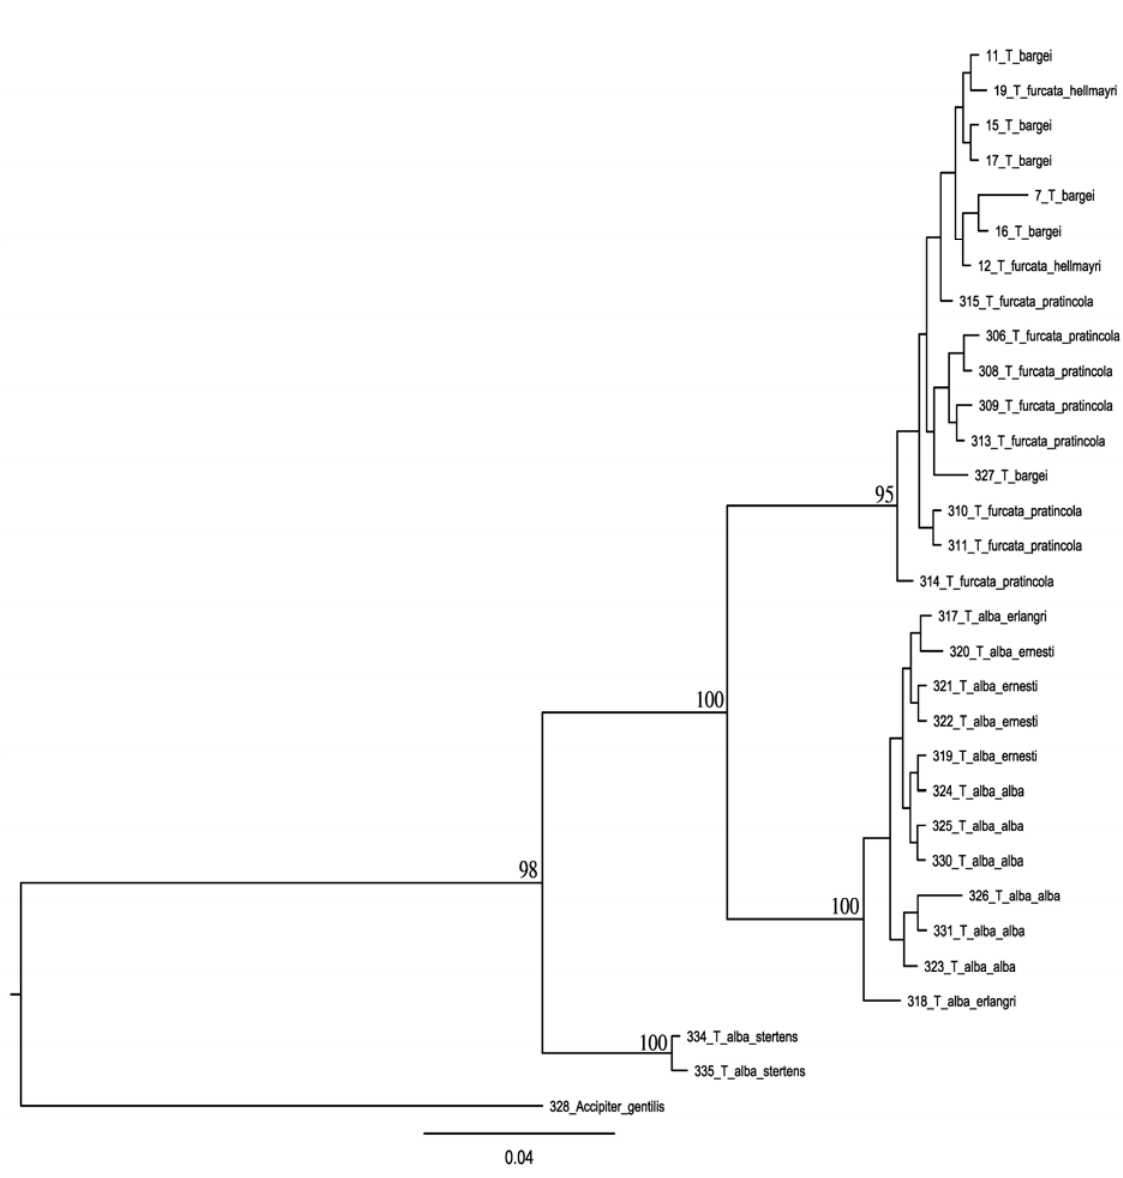
F IGURE 1. Ninety-percent majority-rule consensus tree sampled from the posterior distribution of the most-partitioned analysis. Posterior probability values from the Bayesian analysis are indicated at the >99% (**) >95% (*) significance levels. Numbers represent ML and MP bootstrap values (500/2000 replicates; given only if